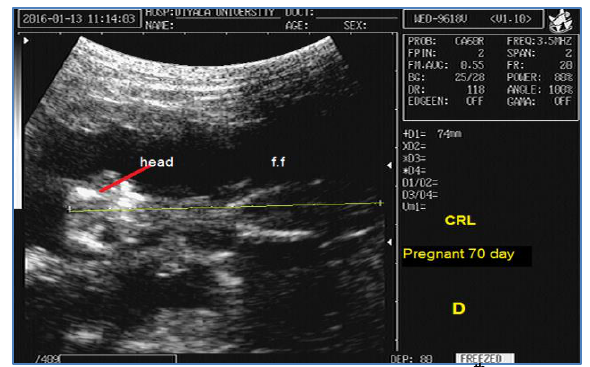
Figure, 4: Measurement of fetal CRL in 10 th week of pregnancy, indicated by straight line (Sector probe, 3.5MHz).